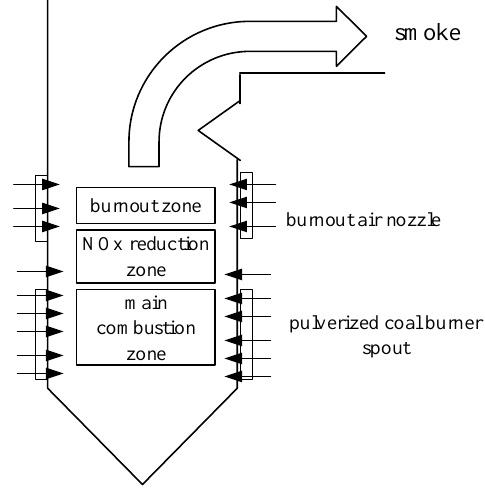
Figure 2. Schematic diagram of pulverized coal combustion.